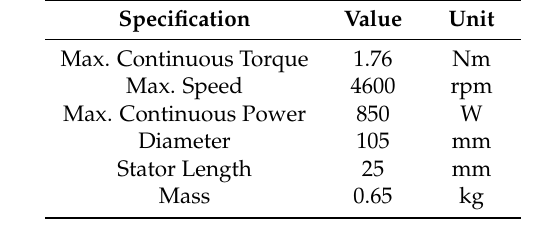
Table 3. Specifications of the actuator in the prototype.